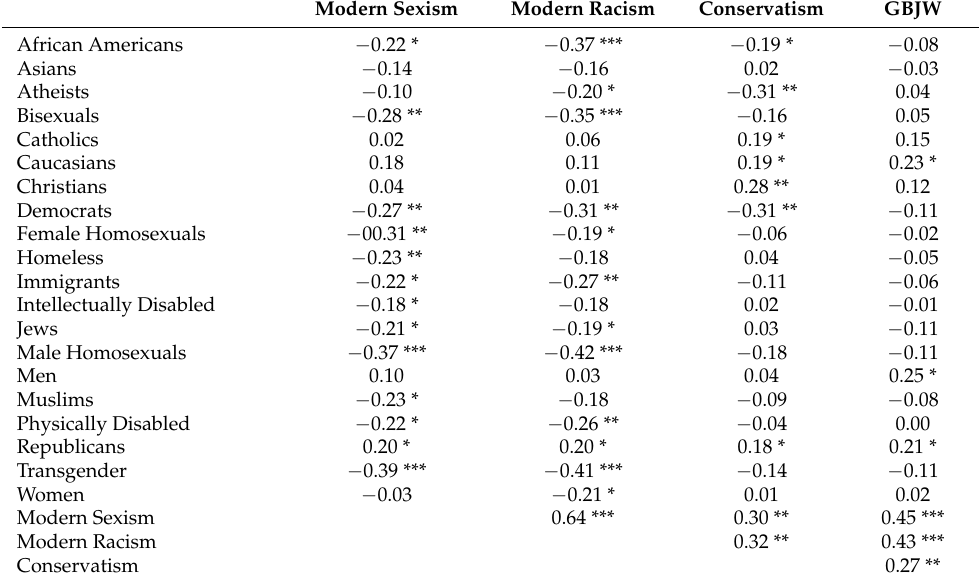
Table 2. Correlations among Liking for Social Groups, Modern Racism, Modern Sexism, Conser- vatism, and